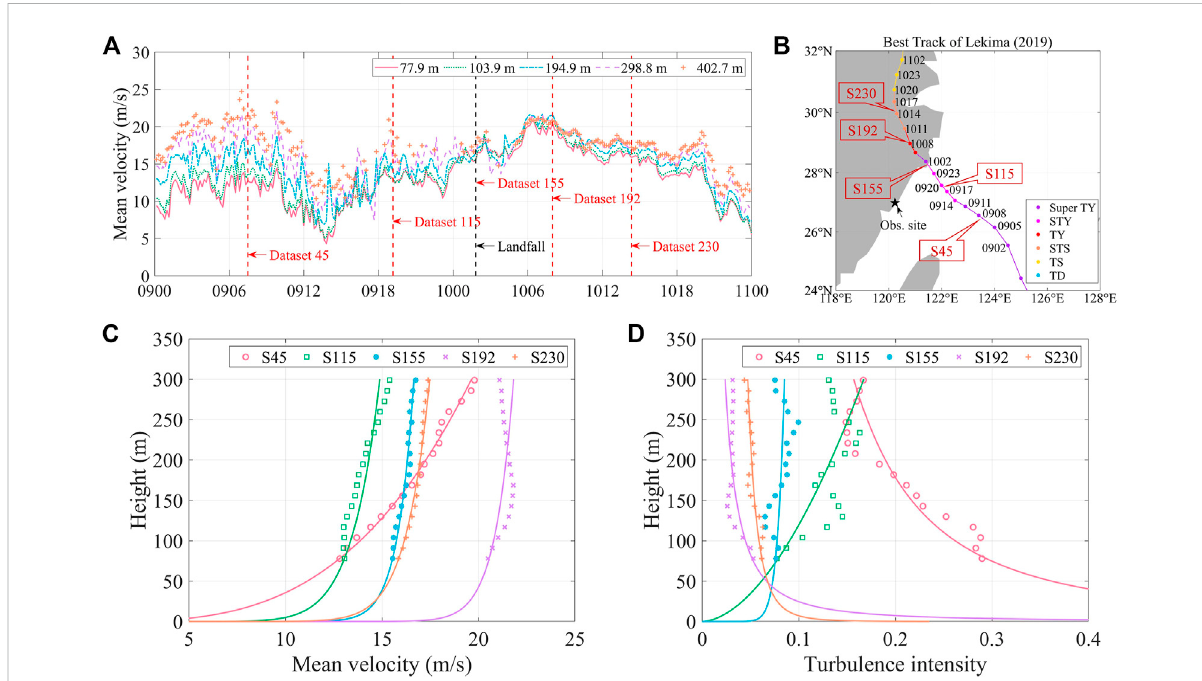
Windspeedpro fi ledeterminedbasedonDWLdata: (A) Indicationofselectedtimeinstantsforwindspeedpro fi leextraction,withhorizontalaxis representingtimeintheformatofdayandhourandverticalaxisrepresentingmeanwindspeed(unit:m/s); (B) Indicationofselectedtimeinstantson Lekima ’ s best track; (C) Power-law fi t for wind speed pro fi le; (D) Power-law fi t for turbulence intensity pro fi